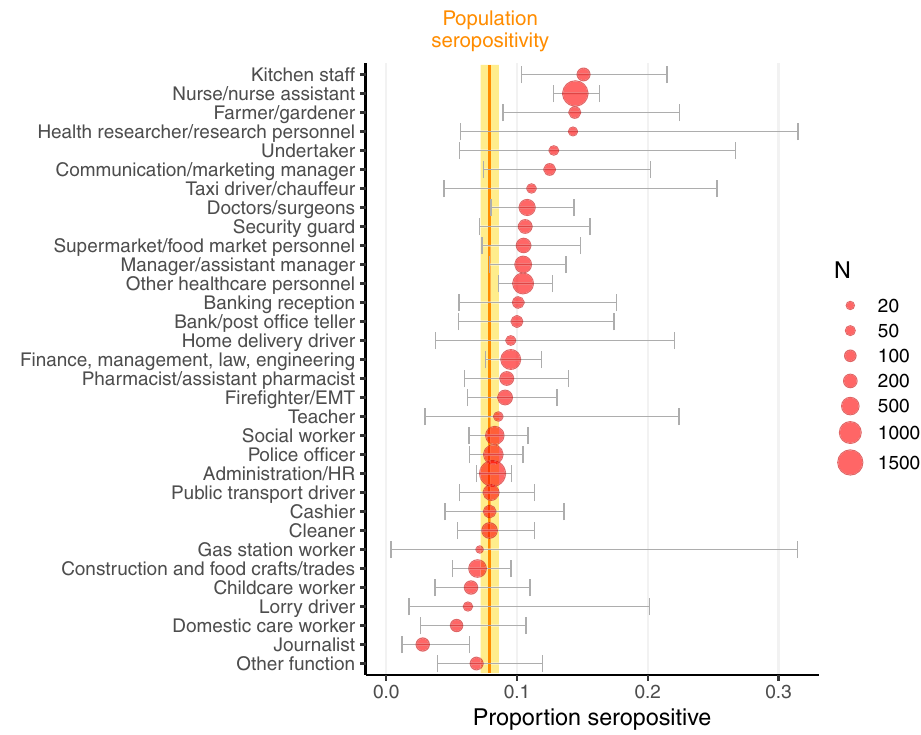
Fig. 2 Prevalence of anti-SARS-CoV-2 IgG antibodies by occupation, SEROCoV-WORK + study, May – September 2020, Geneva, Switzerland. Sample size: 10,513 participants, 1026 of which were seropositive. Red dots indicate mean seropositivity rate for each occupation, while horizontal gray lines represent 95% binomial con fi dence intervals. Dot size indicates number of employees with that occupation. Vertical orange bar and yellow area indicate general working-age population seropositivity rate and 95% binomial con fi dence interval, respectively, from SEROCoV-POP study 20,21